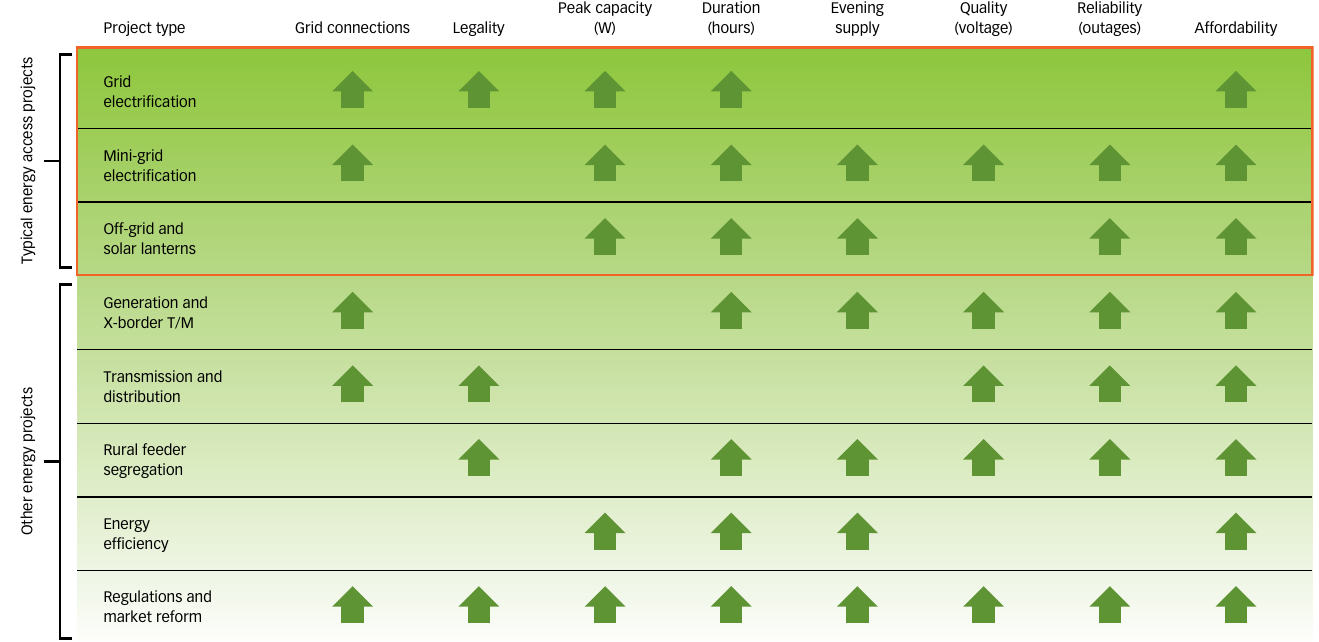
Table 2. Electricity interventions and their potential effect on